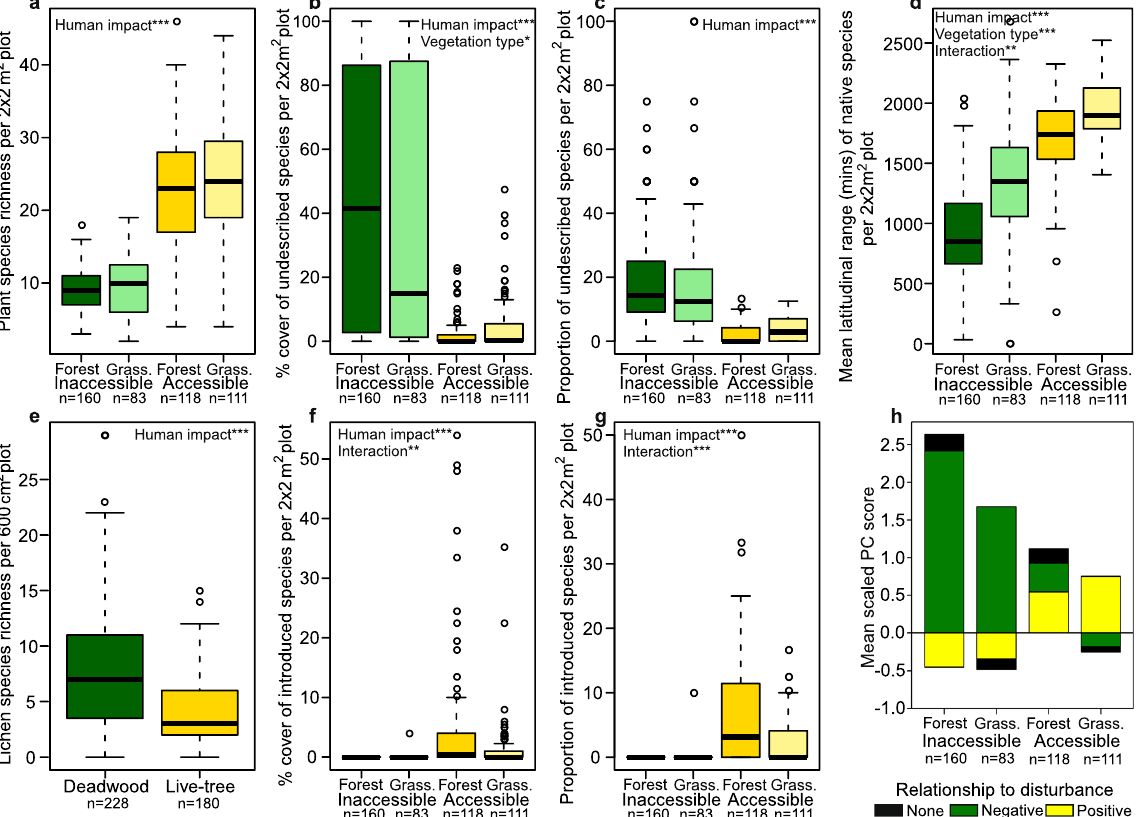
Figure 3. Plant diversity, composition and traits in inaccessible and accessible forest and grassland. ( a – h ) Comparisons of species richness of vascular plants per plot ( a ), cover and proportion of undescribed ( b , c ) and introduced ( f , g ) plant species per plot, and average latitudinal amplitude of native plant species per plot excluding introduced species ( d ). Epiphytic lichen species richness ( e ) is compared between deadwood substrate, generally only found in inaccessible forests (Fig. 2g), and live trees. To compare disturbance-related plant traits ( h ), the cumulative means of scaled principal components, referring to positive and negative disturbance related plant trait syndromes, averaged over all species per 2 × 2 m 2 plot, are compared (Fig. S3 and Table S6). Significant relationships between the structural properties and fixed effects, found upon analysis using GLMM’s, are noted within the plots ( *** p < 0.001, ** p < 0.01, * p < 0.05; Tables S15 and